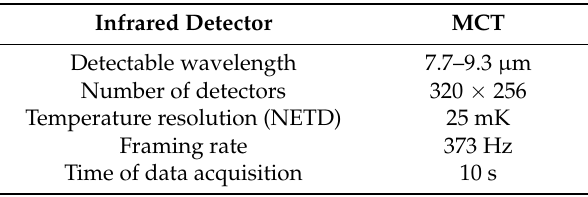
Table 1. Specifications and setting of employed infrared camera